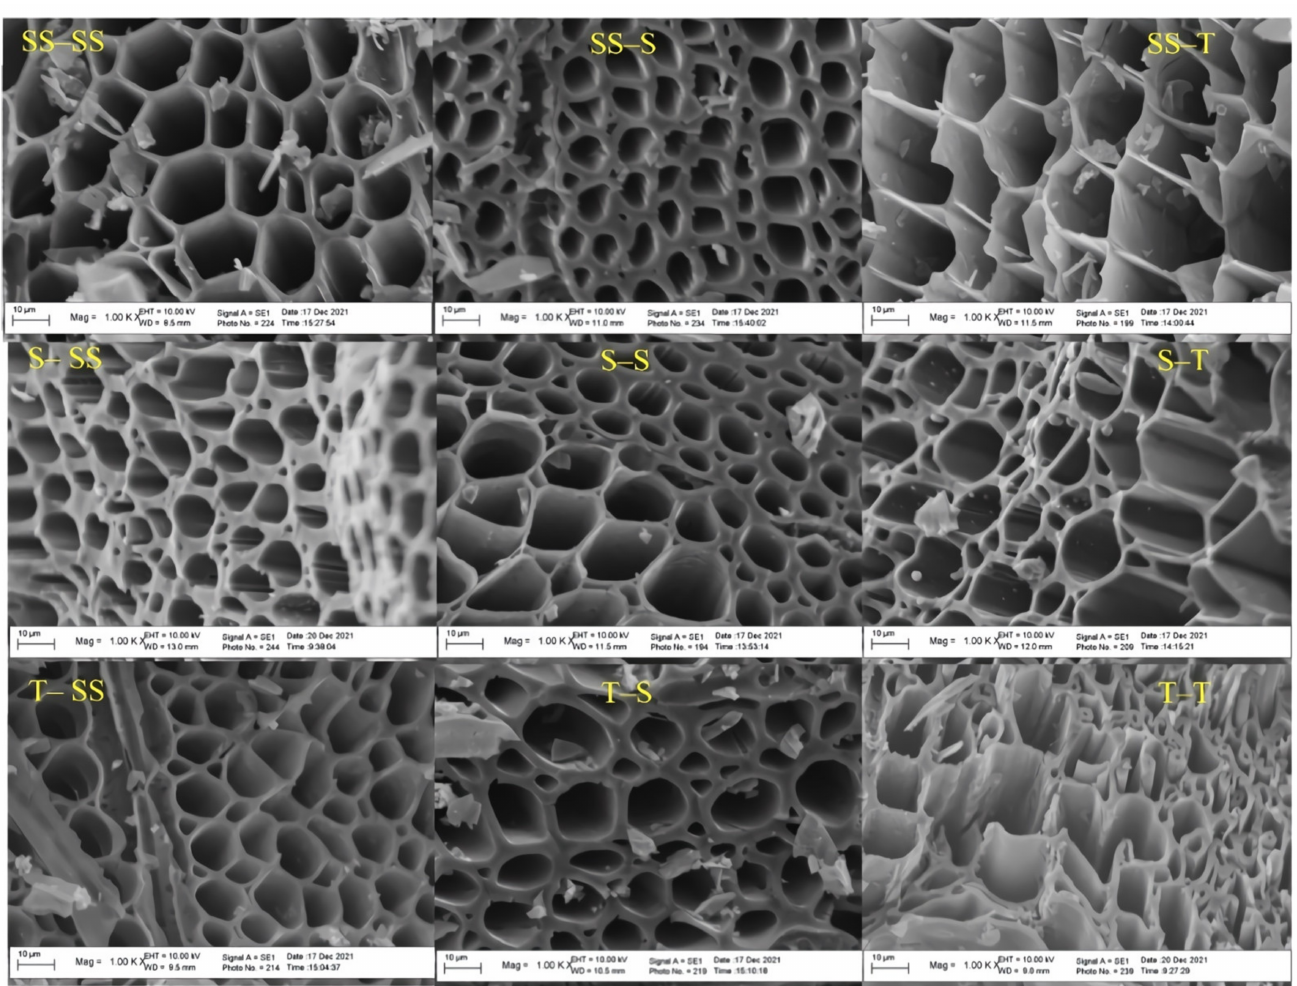
Figure 6. Scanning electron micrographs of prepared activated